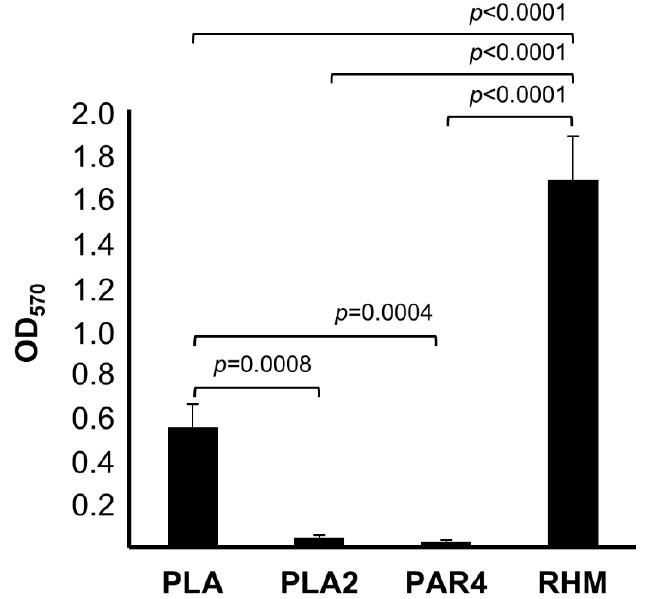
Figure 3. Ability to produce biofilms on plastic surface. Cultures of the tested lactobacilli were inoculated in fresh MRS broth and incubated for five days at 30 ◦ C. Optical density was measured at 570 nm to quantify the plastic-adhering biofilm. Statistical analyses were carried out by ANOVA test ( p < 0.05), followed by Fisher’s Least Significant Difference (LSD) test. Values represent mean ± SD of 3 different experiments.